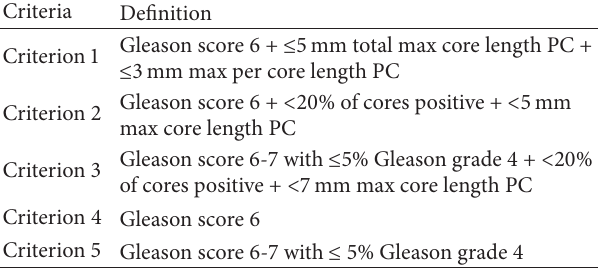
Table 1: Five transperineal saturation biopsy-based criteria for low- risk prostate